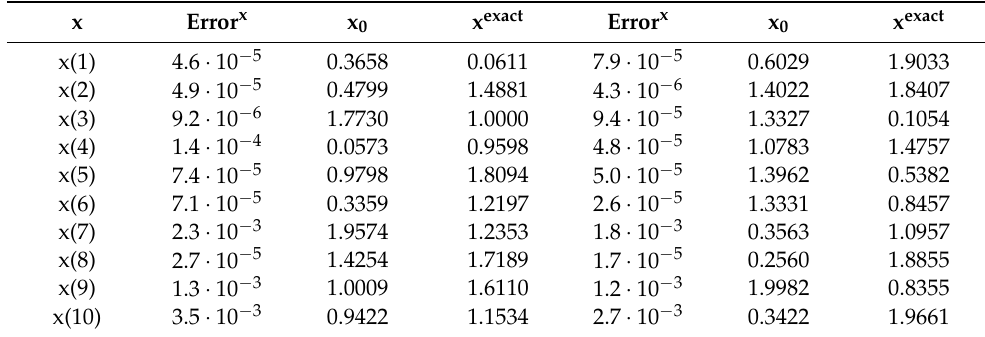
Table 5. Counterpart of Table 3 using the adapted Newton